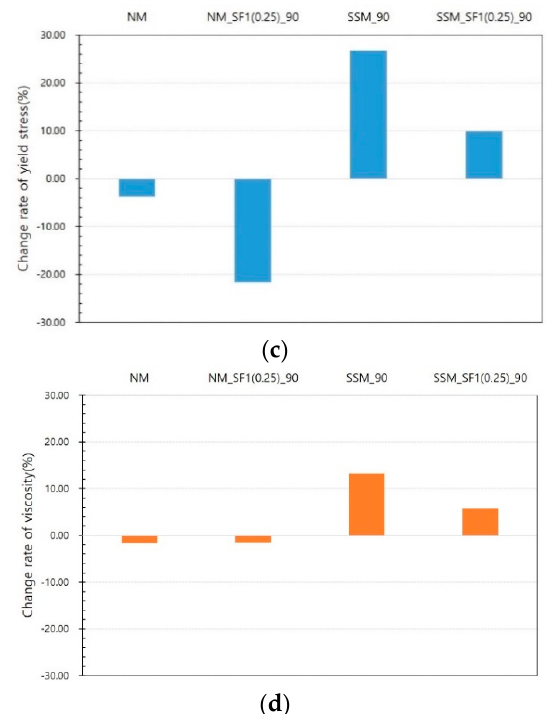
Figure 12. Comparison between normal and steel slag mortars: ( a ) yield stress at 50 V, ( b ) viscosity at 50 V, ( c ) yield stress at 90 V, ( d ) viscosity at 90 V.